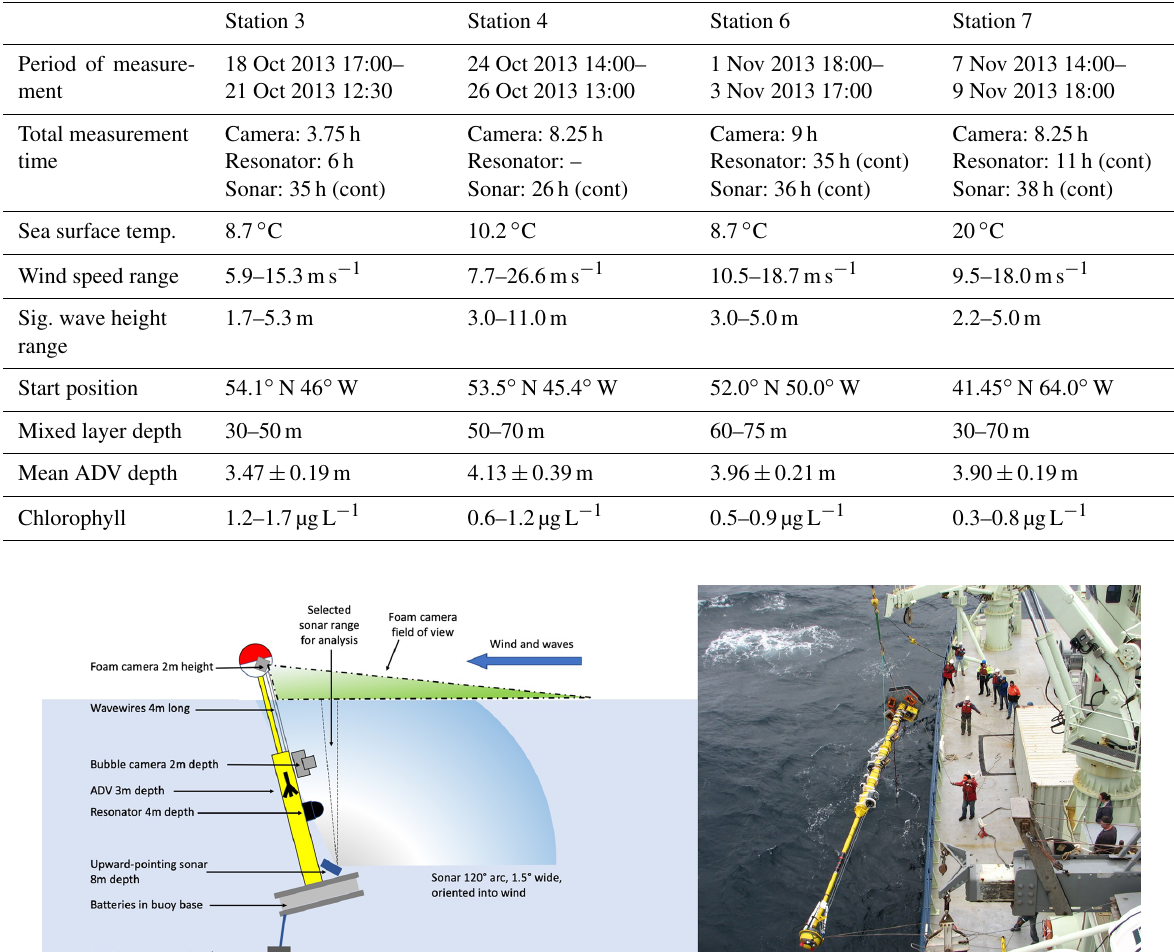
Table 1. Wind speed over the entire HiWinGS expedition. Shaded areas show the times of the four buoy deployments discussed in this paper. All times are UTC.